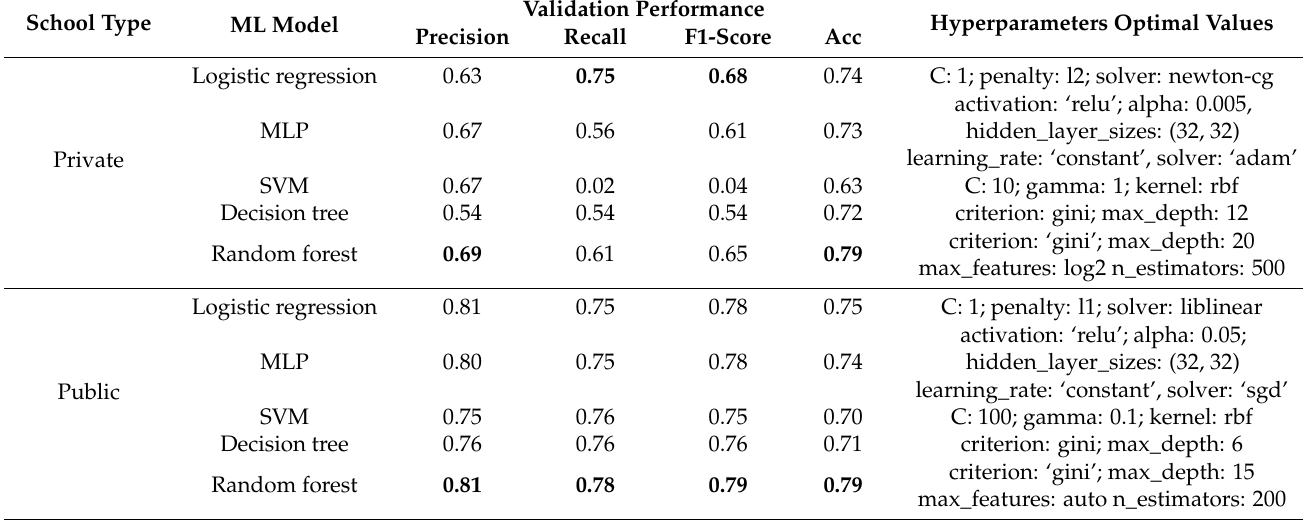
Table 2. Summary of best validation performance per ML model after grid search. Text in bold indicates best ML model performance for a specific metric and school type. For both participants from private and public schools, the best classifier is the Random Forest in terms of